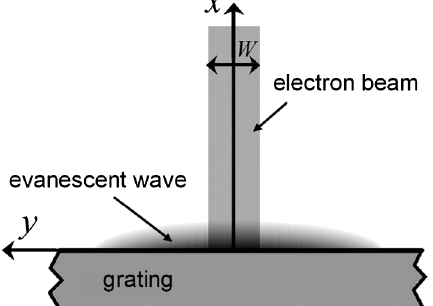
FIG. 2. Geometry of evanescent wave and electron beam, viewed from in front of the